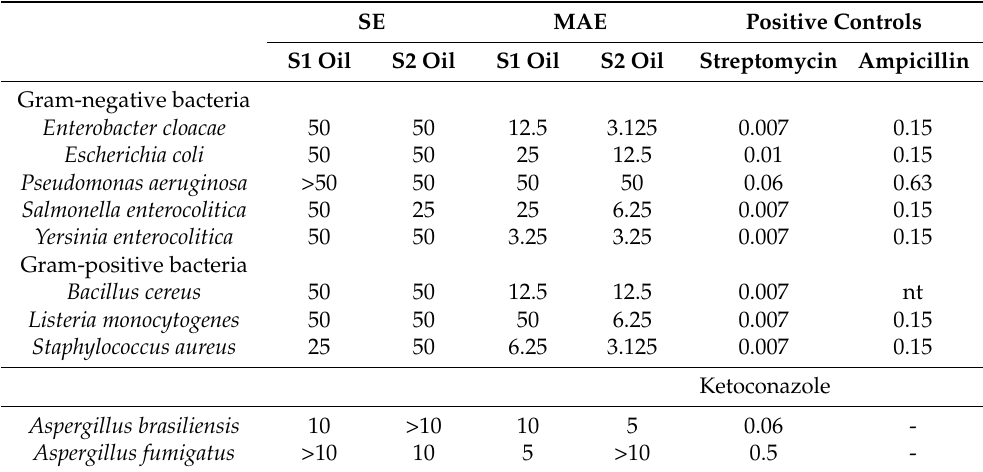
Table 5. Antimicrobial activity of the oils extracted from fish by-products using Soxhlet extraction (SE) and optimized microwave-assisted extraction (MAE). The results are presented as minimum inhibitory concentration (MIC, mg/mL)